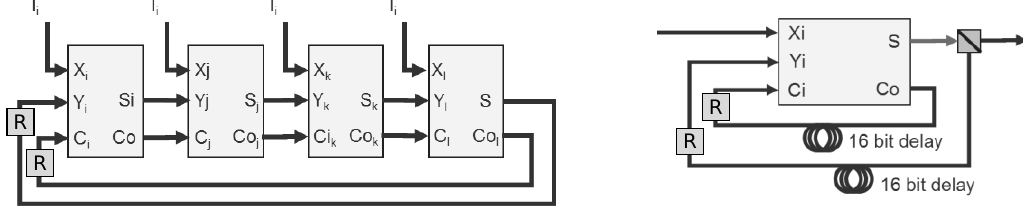
Figure 11. A single full adder implements the Internet checksum, using delayed recirculation with regeneration (indicated by the “R” boxes).